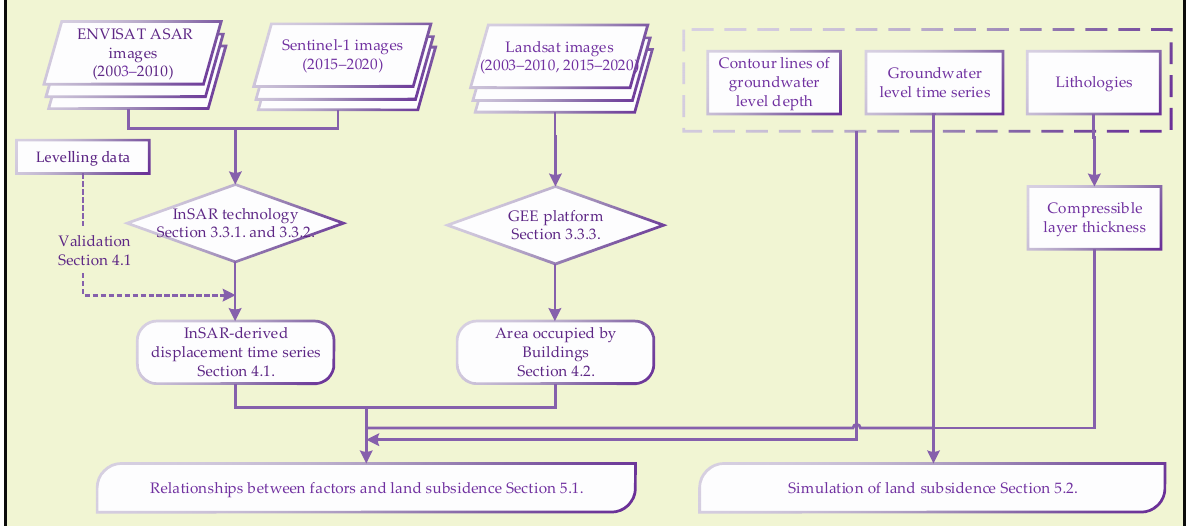
Figure 3. The flowchart of the processing.